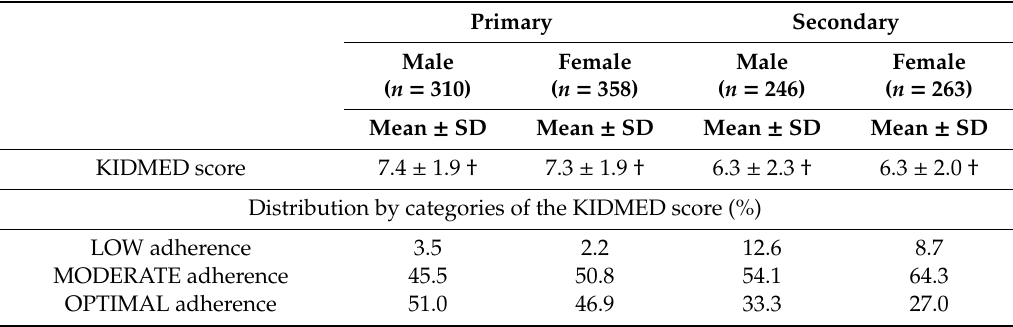
Figure 1. Responses to the questions on the Mediterranean Diet Quality Index for Children and Adolescents (KIDMED index) questionnaire showing the percentage of respondents who gave a ffi rmative answers to each of the 16 questions on the KIDMED questionnaire. *** p < 0.01 using one-way ANOVA. Table 2. Mean scores on the KIDMED index and percentage distribution of the respondents in the three categories of adherence to the Mediterranean diet (MD) (low, moderate, optimal) in accordance with the score obtained on the KIDMED